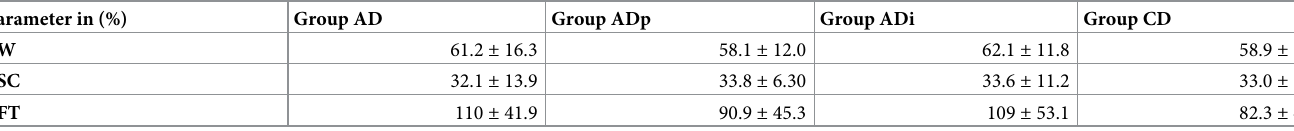
Table 3. Increases in BW, BCS, and BFT in the four feeding groups during the observation period. Parameter in (%)